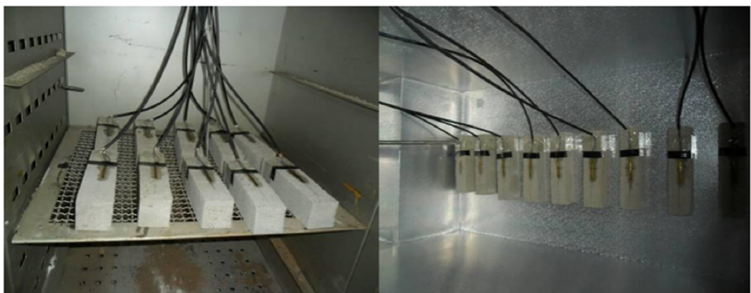
Figure 3. Experiment of temperature shrinkage.